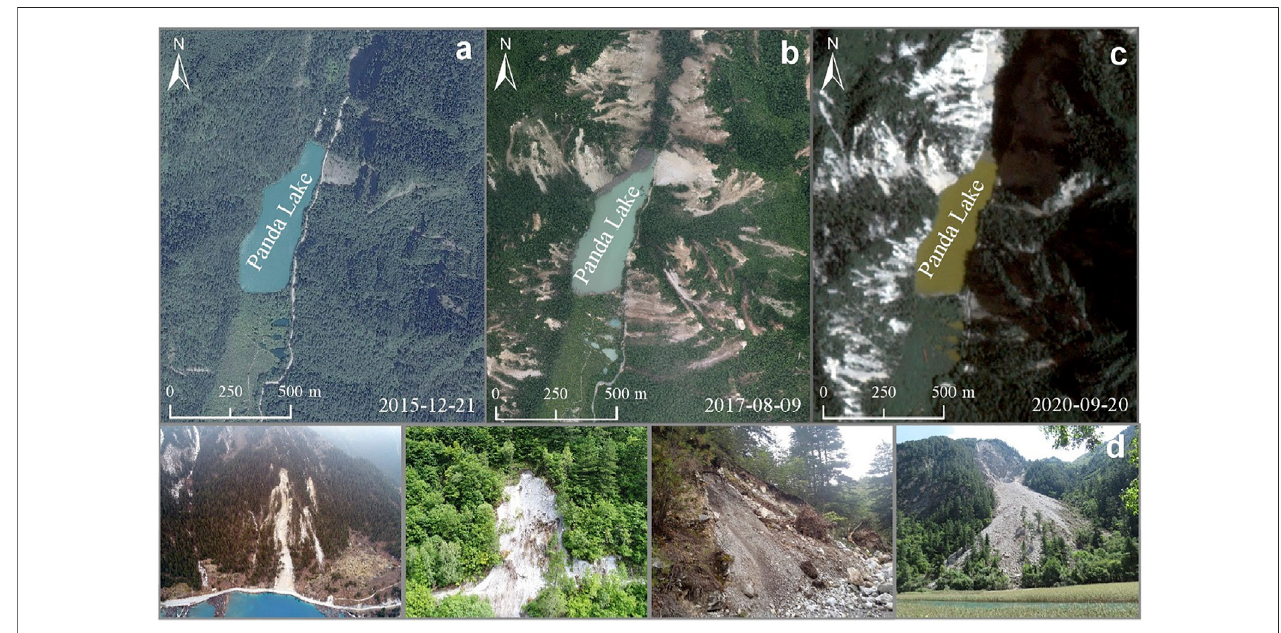
FIGURE 2 | (A) Pre-earthquake, (B) co-seismic, and (C) post-seismic satellite images around Panda Lake for multi-temporal landslide interpretation; (D) Photographs obtained from the fi eld surveys showing typical landslides in the study area.